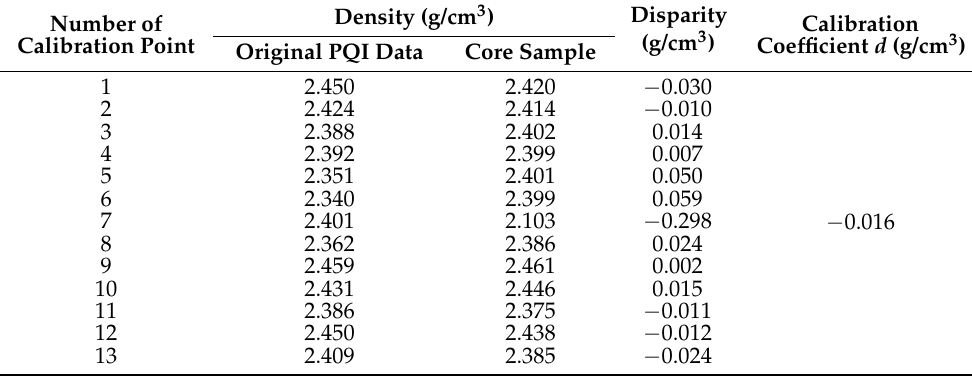
Table 2. Calculation results of calibration coefficient d .